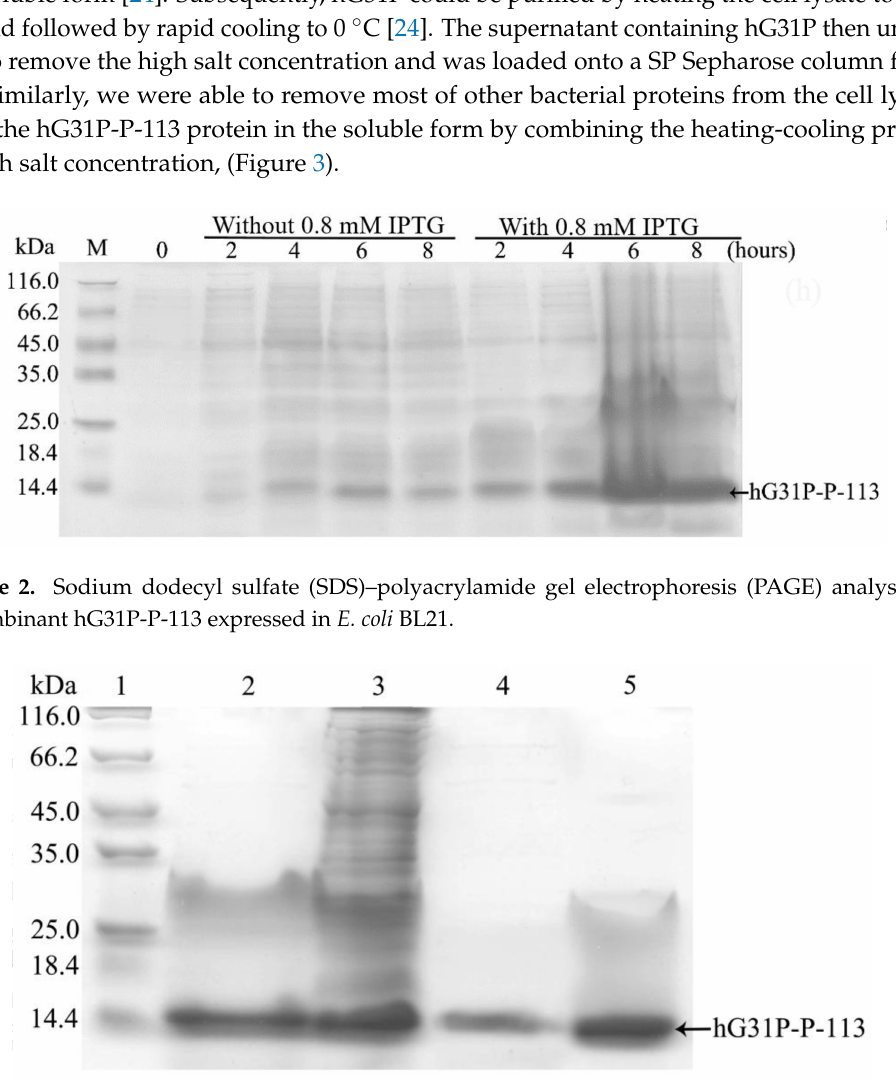
Figure 3. SDS-PAGE analysis of recombinant hG31P-P-113 expressed in E. coli at different steps